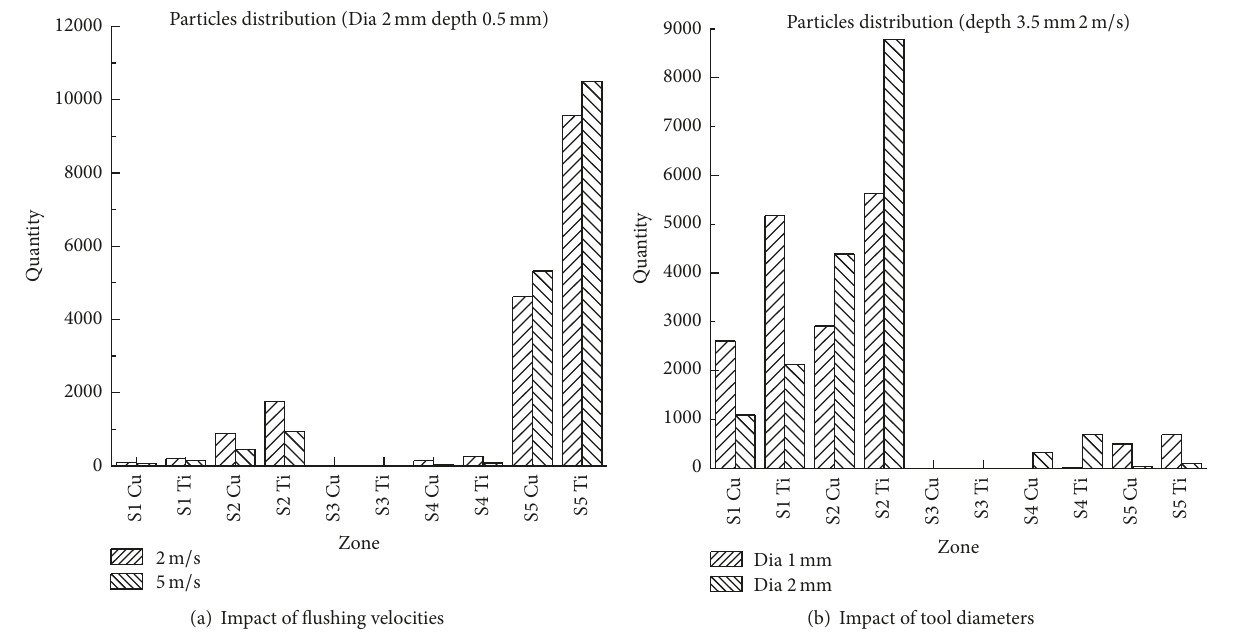
Figure 23: Debris statistical distribution of Cu and Ti in different conditions.